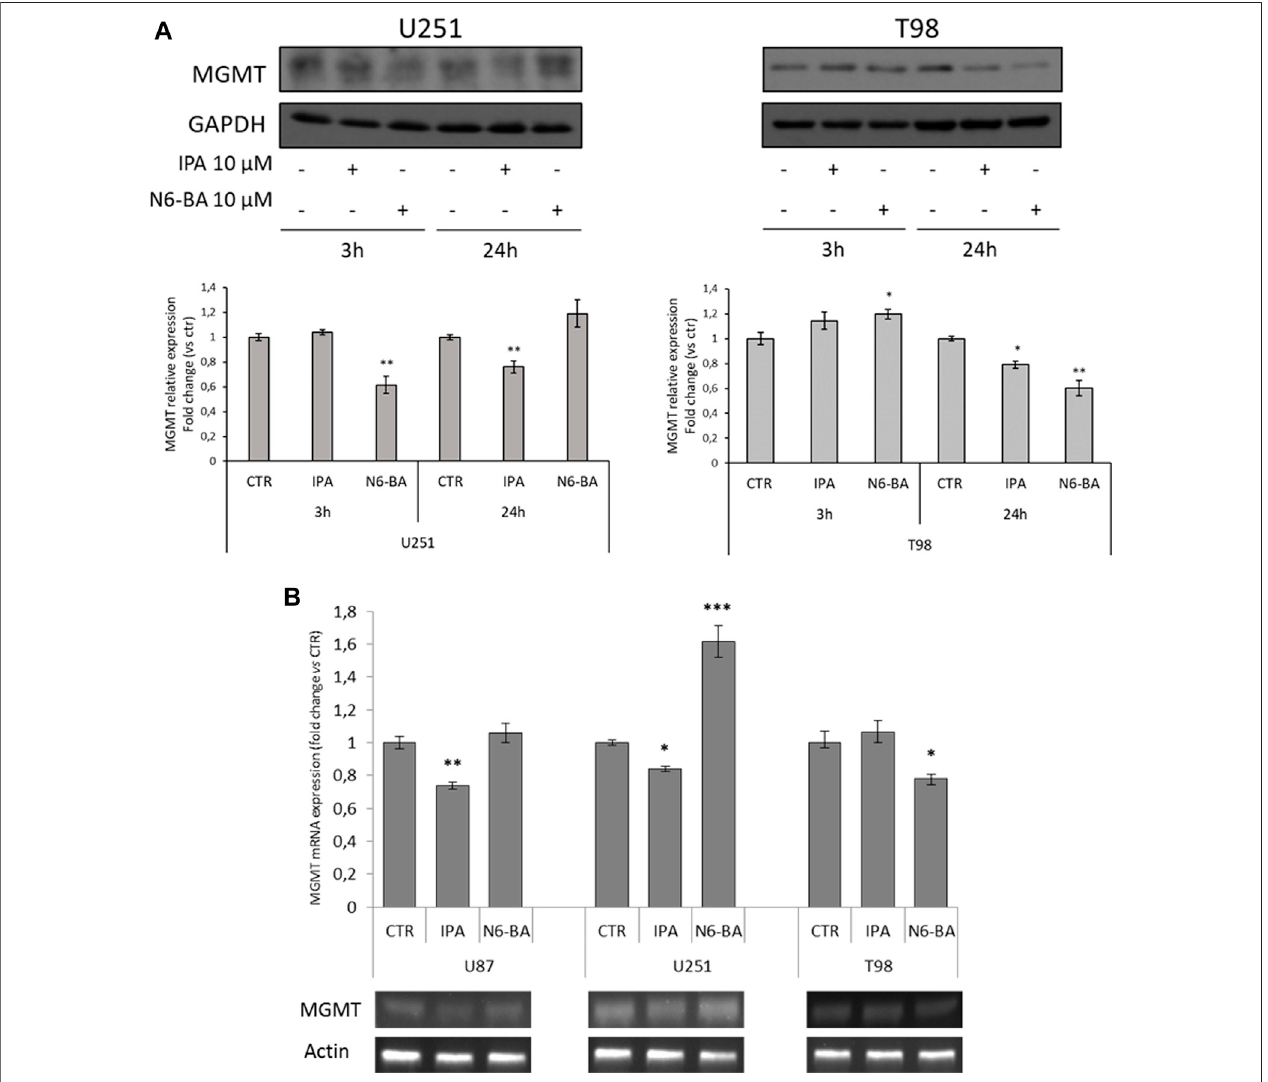
FIGURE 4 | IPA and N6-BA modulate MGMT protein levels. (A) Representative western blot and densitometric analysis of MGMT protein expression in U251 and T98 cellstreated with10 µM IPAor 10 µM N6-BA. GAPDH wasused asaloadingcontrol. (B) RepresentativeMGMT mRNA expression (lower panel) and densitometric analysis (upper panel) in U87, U251, and T98 cells treated with 10 µM IPA or 10 µM N6-BA, for 24 h. Data are expressed as mean ± SD of at least three independent experiments. * p < 0.05, ** p < 0.01, and *** p < 0.005 vs. control.